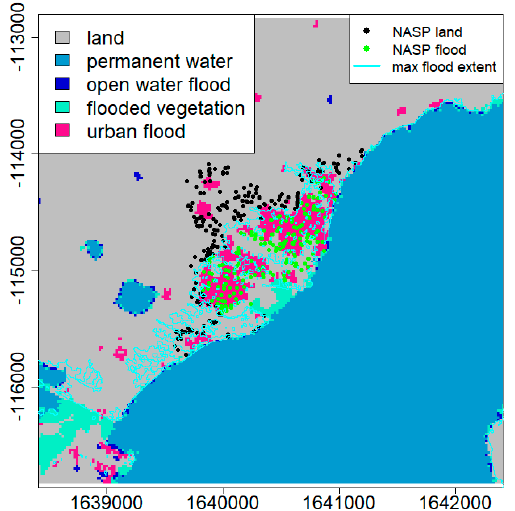
Figure 6. CCD urban flood extents of Sainte-Marthe-sur-le-Lac with the maximum flood extents from high-resolution optical imagery and validation points interpreted as either flood (blue) or land (green) from NASP imagery acquired on April 29, 2019.